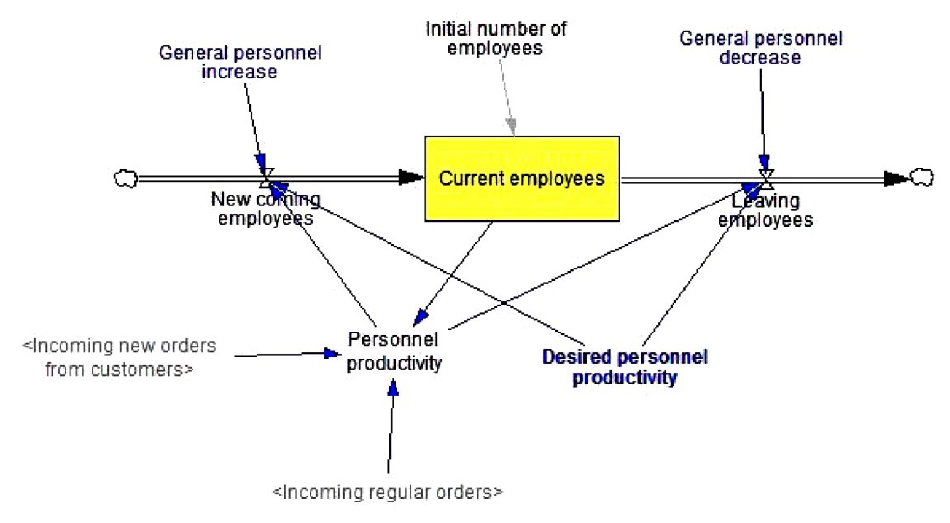
Fig. 6. 3PL personnel model (developed by the